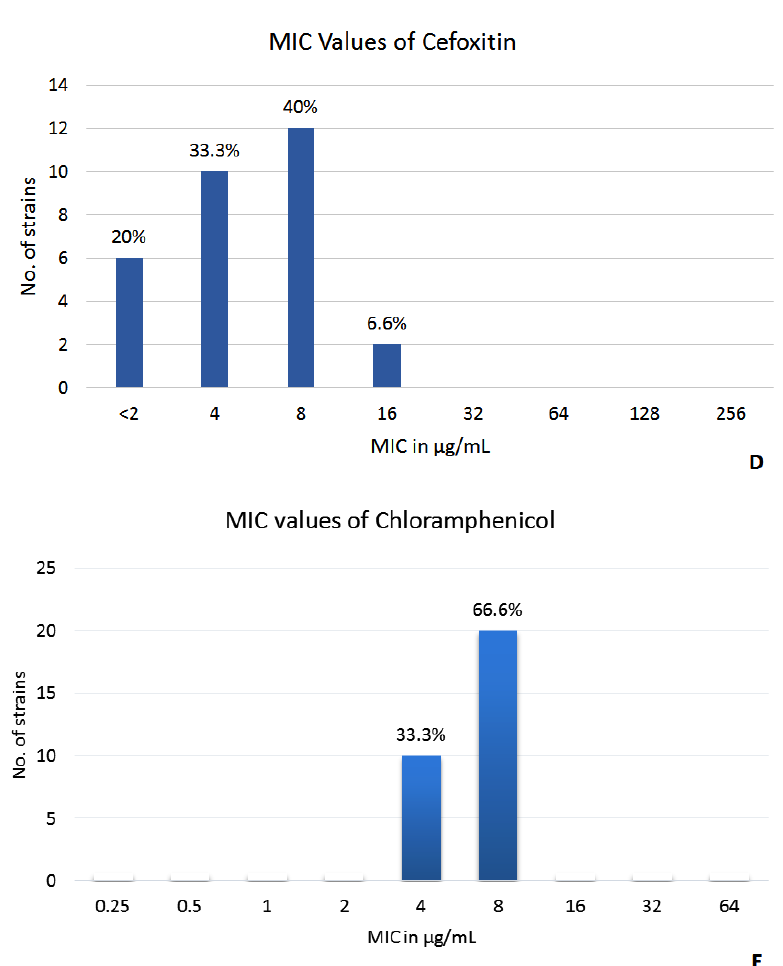
Fig. 2. MIC distribution among P. anaerobius isolates to Metronidazole (A), Clindamycin (B), Penicillin (C), Cefoxitin (D) and Chloramphenicol